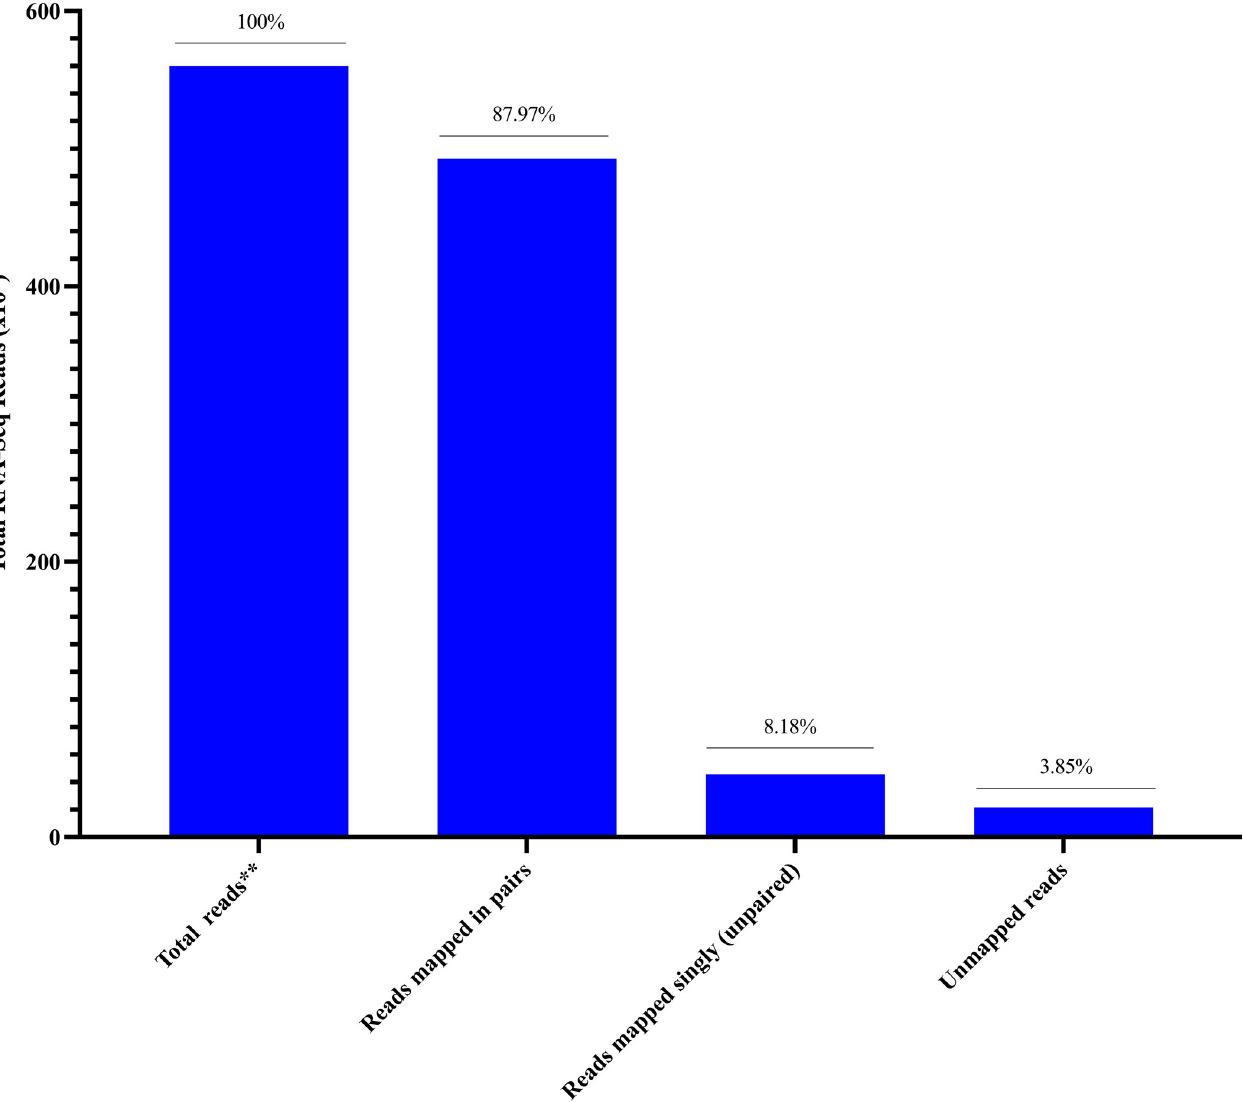
Fig 3. Quality assessment of read representation in de novo assembled antennal transcripts from male G . m . morsitans RNA-Seq antennal libraries. We de novo assembled the unmapped reads into transcripts and assessed quality of the assembled transcripts using short reads Trinity de novo assembly software 2.10.0 [41] that mapped the reads onto their respective assembled transcripts to account for individual reads (incorporation). https://doi.org/10.1371/journal.pone.0273543.g003 4.55%, potentially adding to the 13,018 number of genes in the G . m . morsitans transcripts gene-set version 1.9 [28], and established that we can uncover new genomic/biological infor- mation from unmapped reads from the antennae-expressed G . m . morsitans transcripts. The significant ( > 96%) mapping of the antennae expressed reads onto the genome indicate suffi- cient (quality) assembly of the reference genome. However, mapping statistics of the reads onto the transcripts points to 1) a major gap (incompleteness) in annotations of G . m . morsi- tans genome, 2) potential under representation of composition of genes present in G . m . morsi- tans genome, and 3) deficiency in annotation of some tissues specific/expressed genes in G . m . morsitans . Total number of annotated coding genes in G . m . morsitans is considerably smaller (by more than 50%) than for D . melanogaster [13], which may be due to genes that have not